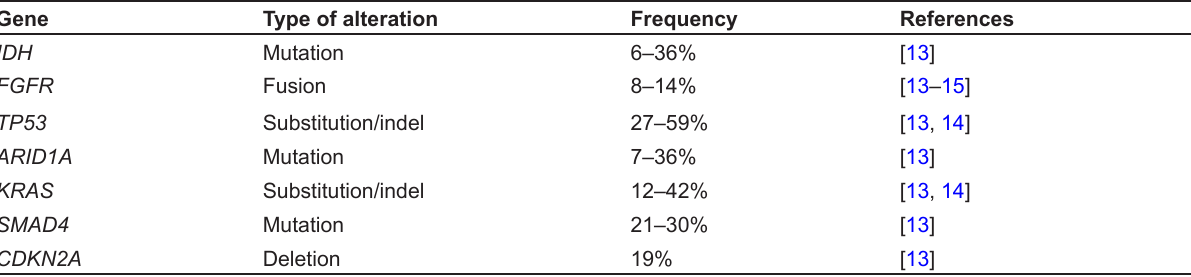
Explor Target Antitumor Ther. 2022;3:362–74 |